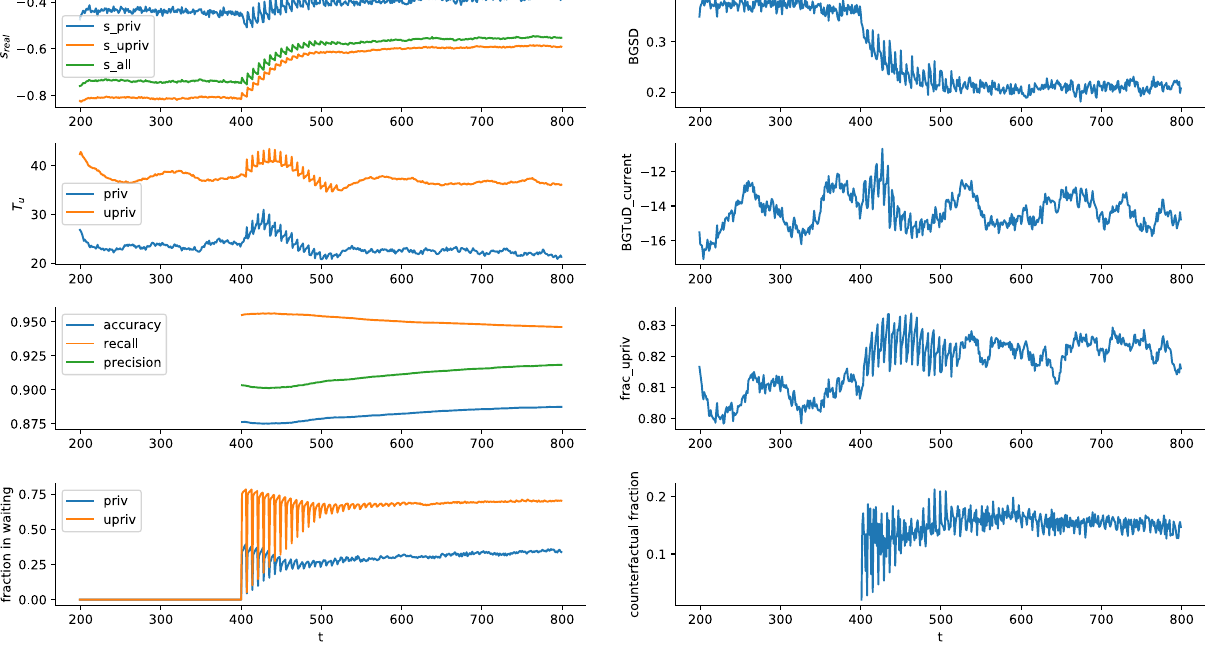
Figure 3. Time evolution of a single model run with the onlylow scenario and full (including protected attribute) prediction model. The First 200 timesteps are discarded, at timestep 400 the PES starts its intervention, which can be seen in several parameters (e.g. increase in s real , decrease in BGSD ). Some parameters/metrics are only available from the time the intervention